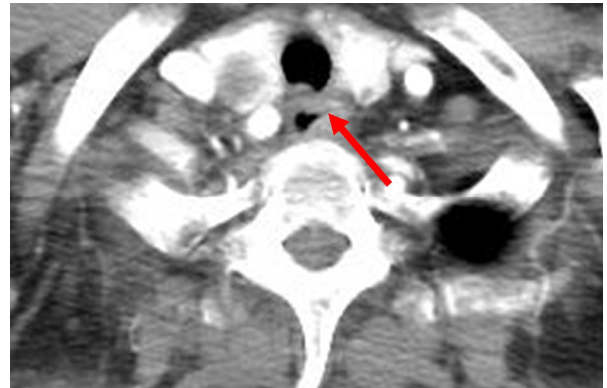
Figure 5. A 76-year-old woman with acute phlegmonous esophagitis. Axial contrast-enhanced CT image at 1st thoracic vertebral level shows a hypodense linear tract (arrow) running from esophageal